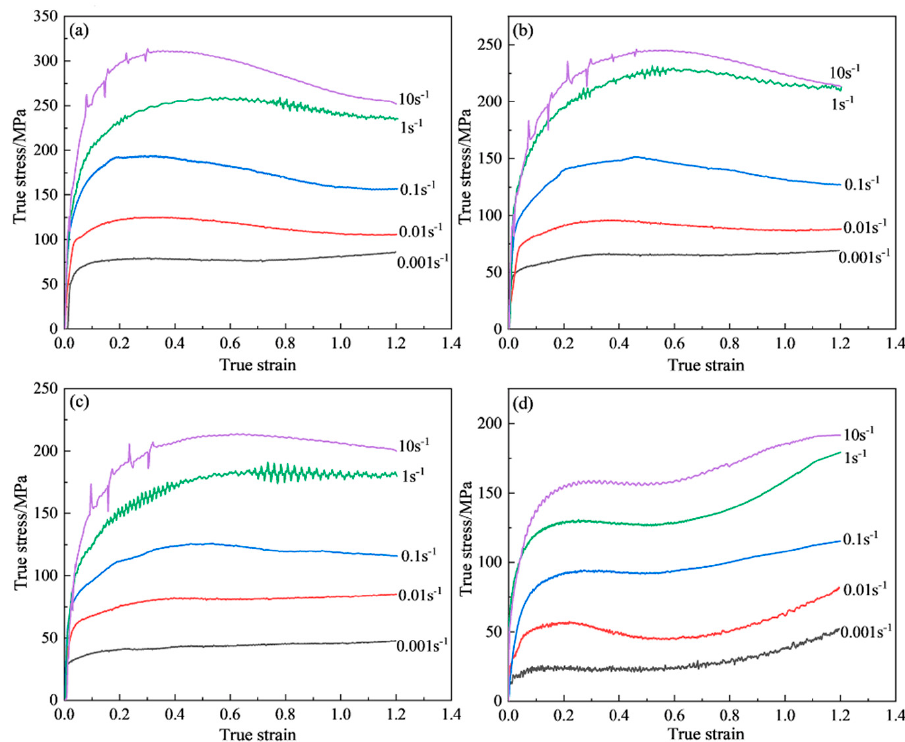
Figure 2. Flow-stress curves under different deformation conditions. ( a ) 1000 °C; ( b ) 1050 °C; ( c ) 1100 °C; ( d ) 1150 °C.